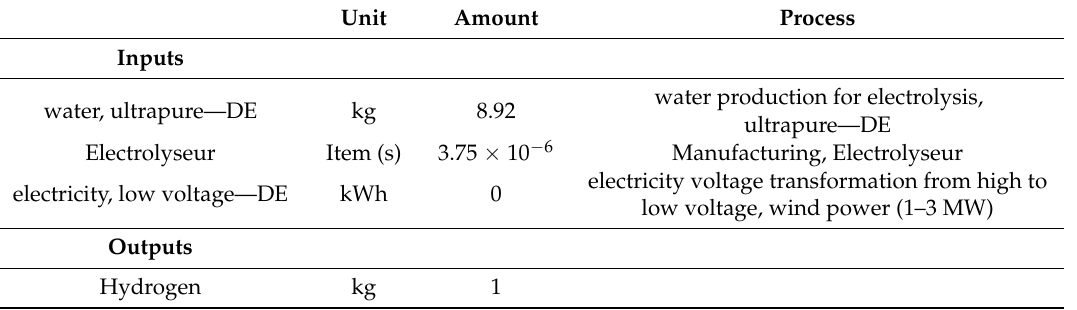
Table A10. Production, Hydrogen.